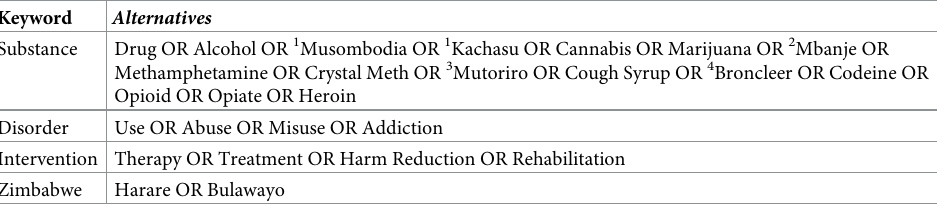
Boolean operators (AND/ OR) will be used to combine search terms, together with truncations for capturing term variations (e.g. Addict � ) as appropriate for each database.